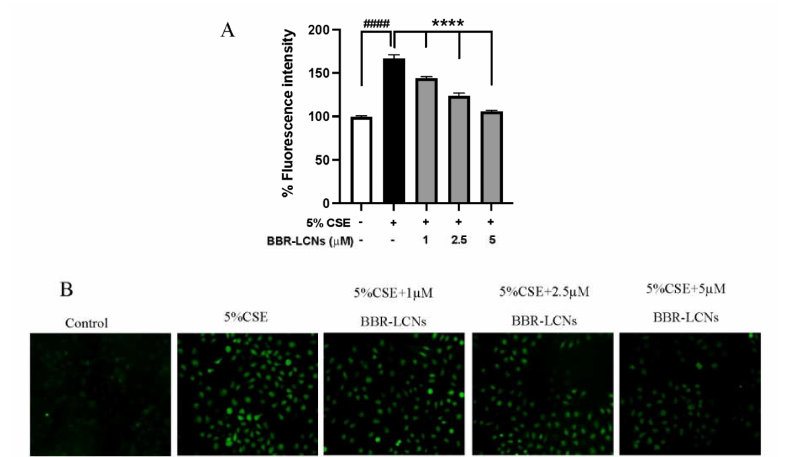
Figure 2. Effect of BBR-LCNs on ROS production in 16HBE cells. ( A ) Measurement of fluorescence intensity. The fluorescence intensity was measured at an excitation 485 nm and an emission 535